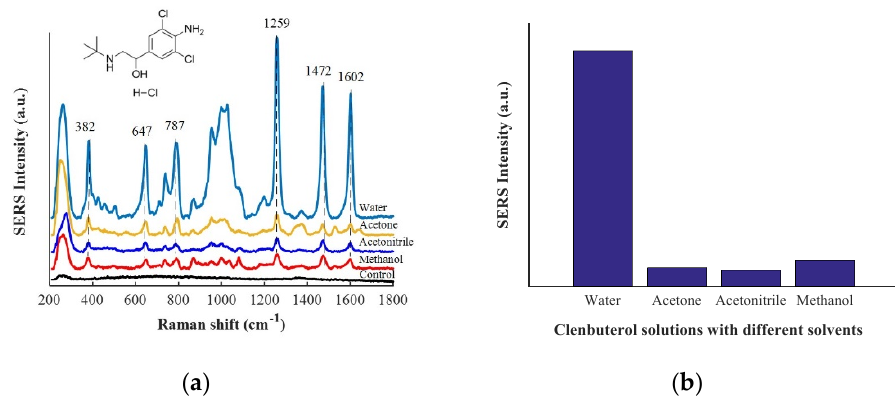
Figure 3. ( a ) SERS spectra of clenbuterol (10 μ g/mL) in different solvents and SERS spectra of water as a control group; ( b ) SERS intensity of clenbuterol at 1259 cm − 1 in different solvents.